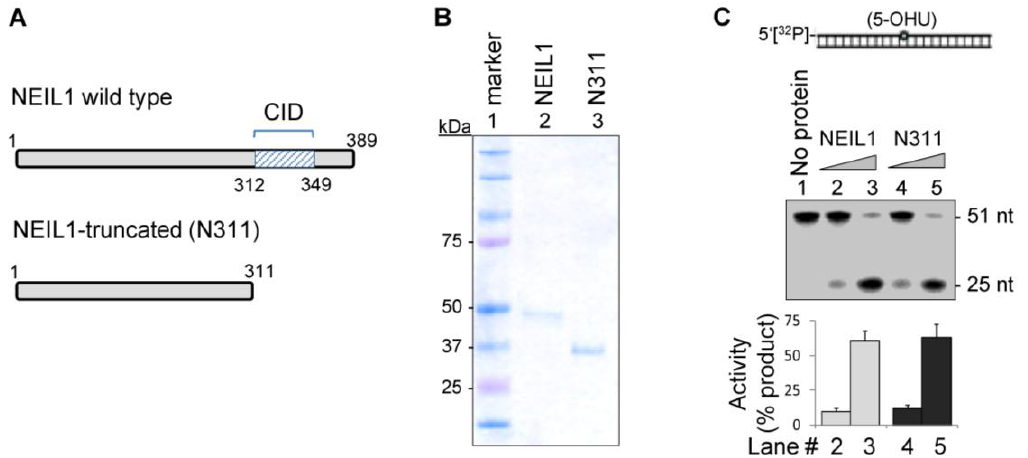
for DNA glycosylase activity in vitro. Recombinant wild-type (WT) and truncated (N311) mutant of NEIL1 (A; Coomassie-stained gel in B) show similar DNA glycosylase/AP lyase activity with a 5-OHU-containing 5'- 32 P-labeled 51-mer oligonucleotide duplex substrate to produce 25 nt oligo (C). Lanes 2 and 3: 10 and 50 fmol WT NEIL1; lanes 4 and 5: 10 and 50 fmol N311